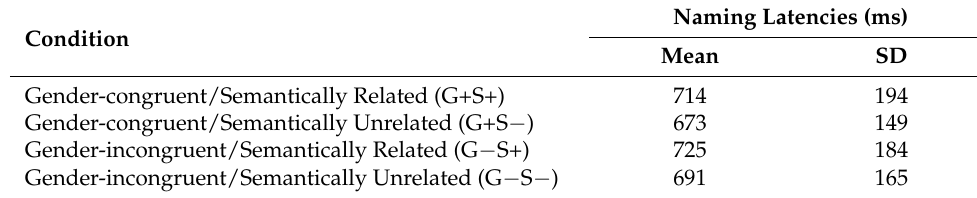
Table 2. Mean picture naming latencies by condition.